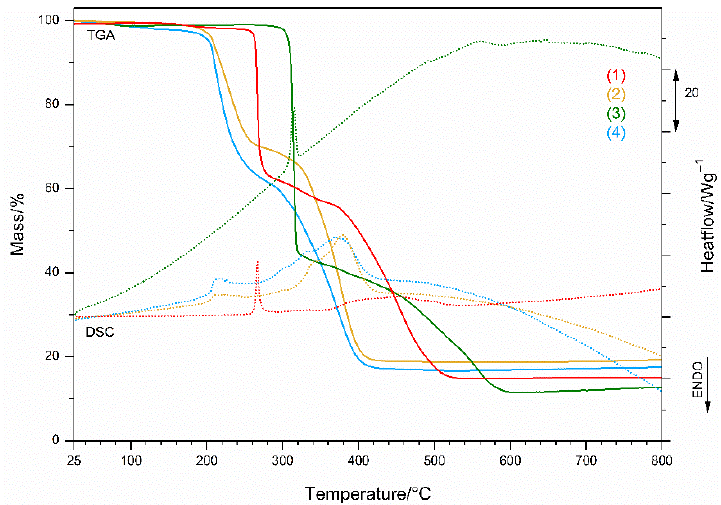
Figure 7 . TGA (lines) and DSC (dotted) curves for all complexes. Figure 7. TGA (lines) and DSC (dotted) curves for all